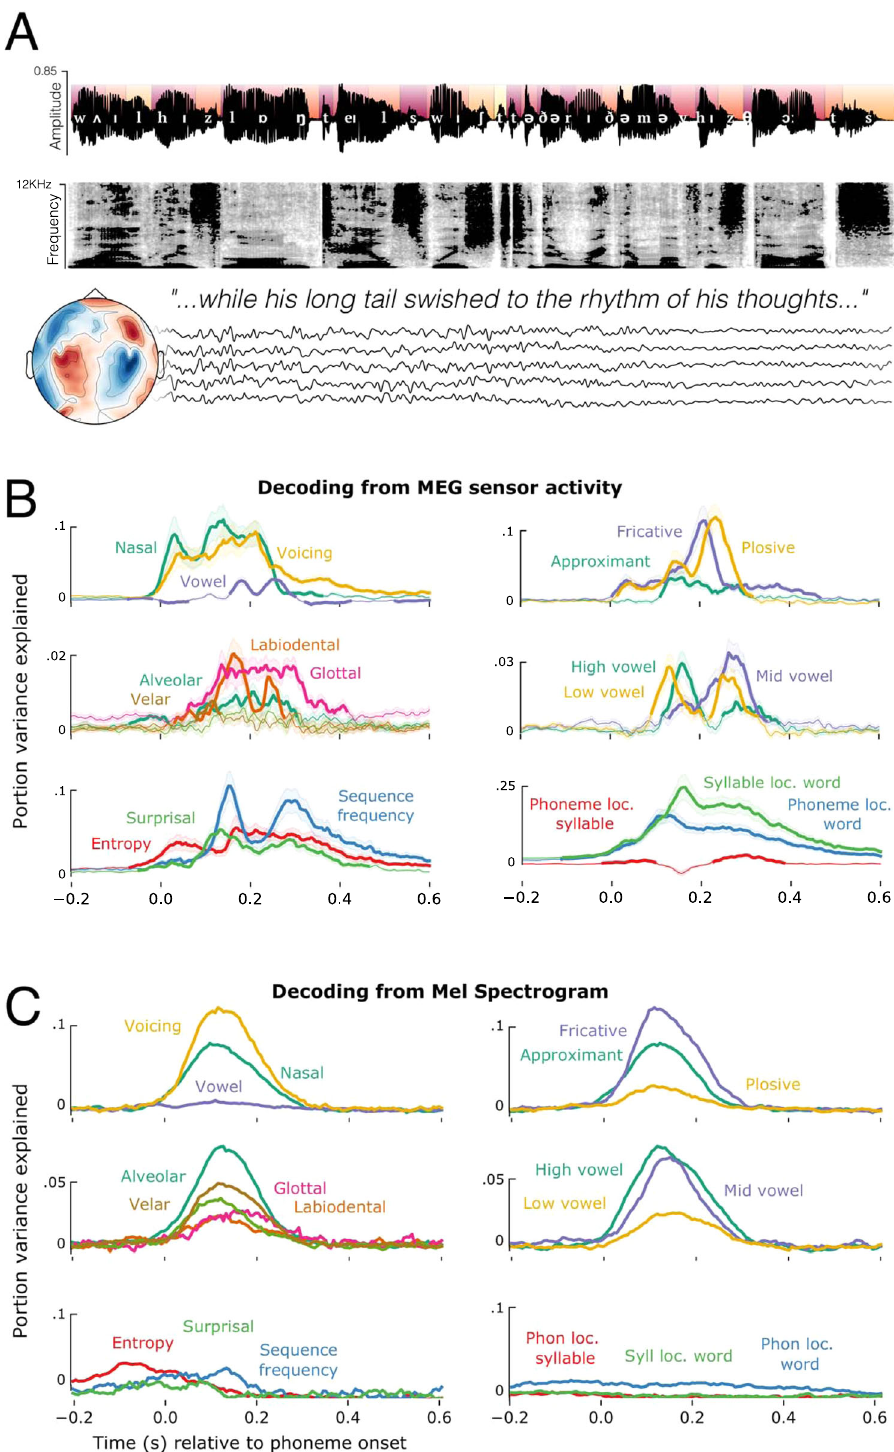
Fig. 1 | Experimental design and phoneme-level decoding. A Example sentence, with the phonological annotation superimposed on the acoustic waveform. Col- ours of the segments at the top half of the waveform indicate the phoneme ’ s distance from the beginning of a word (darker red closer to word onset). The spectrogram of the same sentence appears below the waveform. Five example sensor residualtime-courses are shown below, indicating thatall recordings of the continuous stories were recorded with concurrent MEG. B Timecourses of